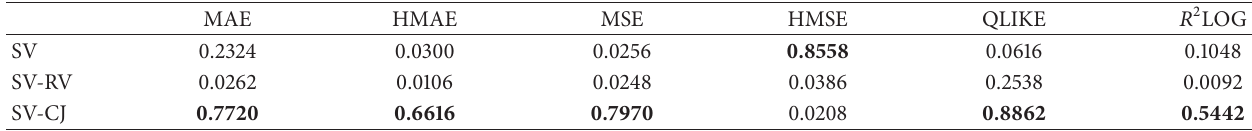
Table 6: The SPA test results of out-of-sample